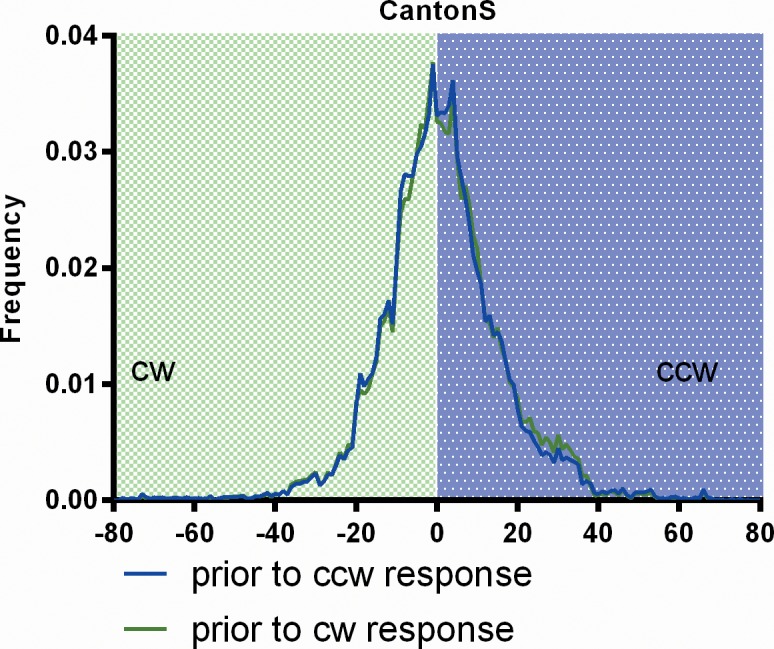
No influence of yaw torque on response polarity.Histograms of CantonS yaw torque generated within 1s before stripes where displaced. For each measurement the data were categorized according to the polarity of the response (cw or ccw; N = 100).